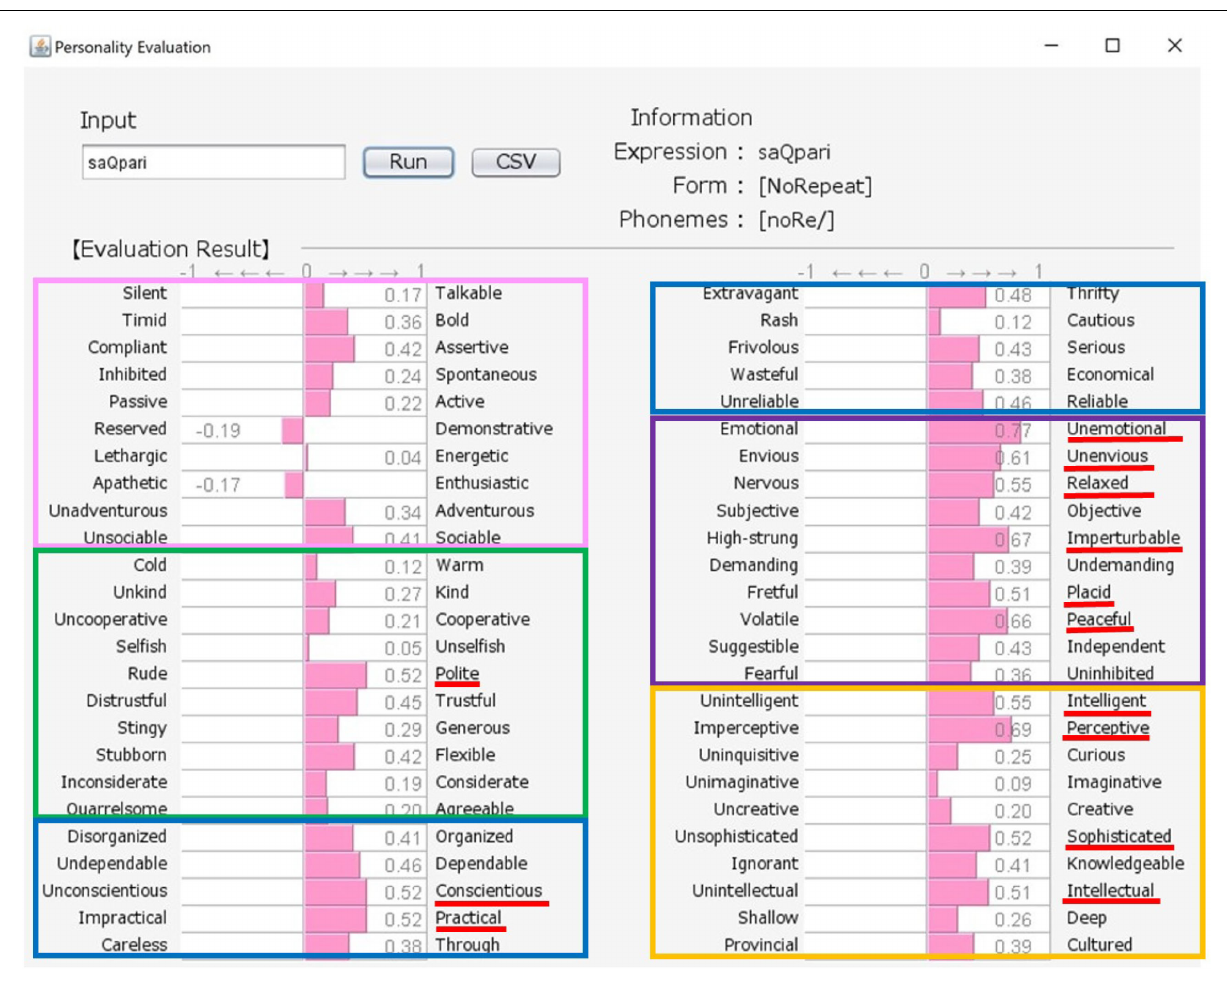
Frontiers in Psychology |